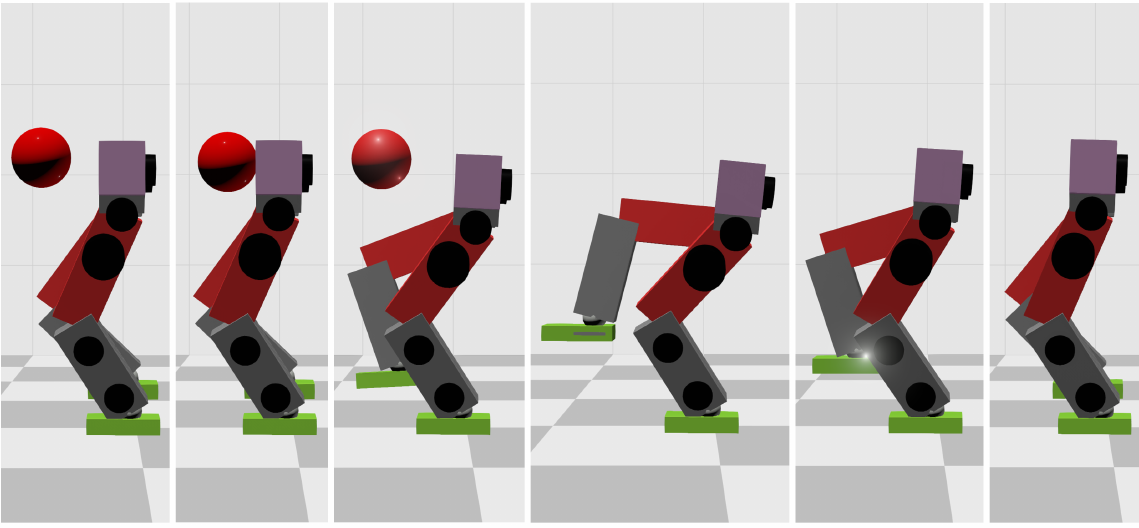
Figure 8. Screenshots of the motions generated by our method in the frontal impact test.